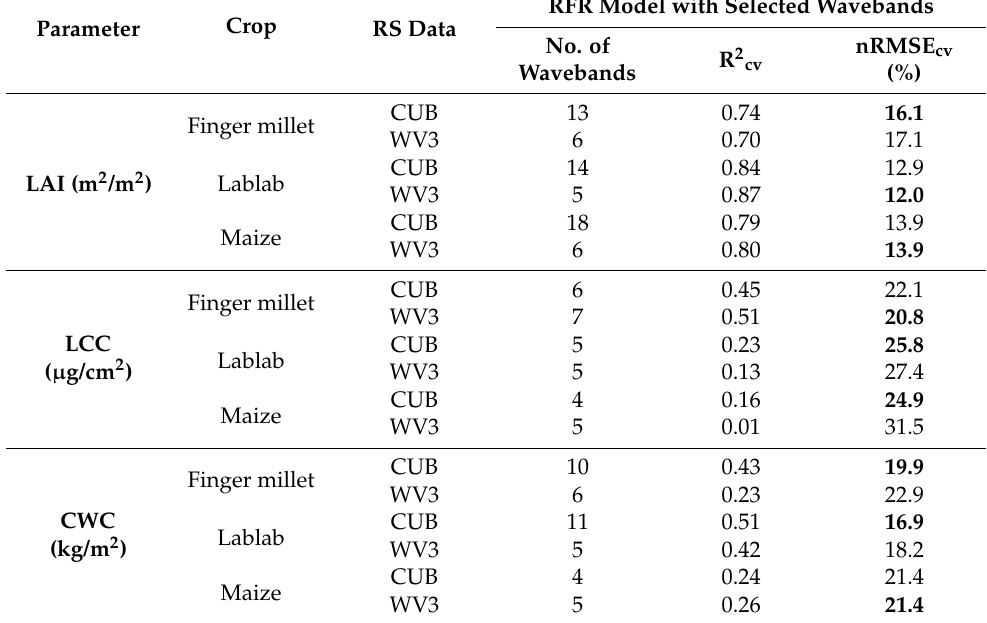
Table 6. Summary of the crop parameter estimation model results from random forest regression (RFR) using selected wavebands. Bold values indicate the lowest nRMSEcv values among the two remote sensing datasets for each crop type. (LAI: leaf area index, LCC: leaf chlorophyll content, CWC: canopy water content, CUB: Cubert, WV3: WorldView3, R 2 cv : coefficient of determination from cross-validation, and nRMSE cv : normalised root means squares error from